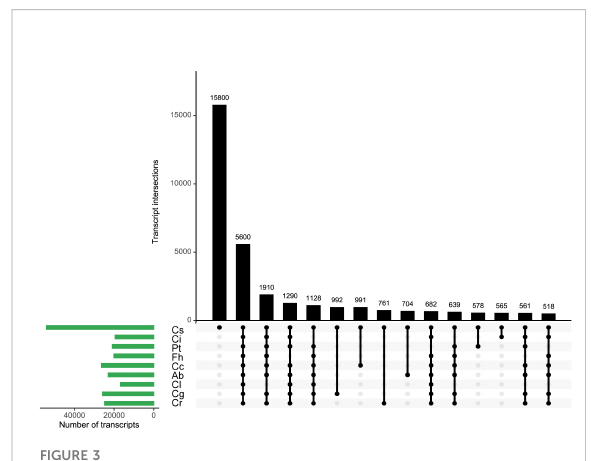
FIGURE 3 Identi fi cation of common and speci fi c transcripts across 9 species. Atalantia buxifolia ; Cc, Citrus clementina ; Cg, Citrus grandis ; Ci, Citrus ichangensis ; Cl, Clausena lansium ; Cr, Citrus reticulata ; Cs, Citrus sinensis ; Fh, Fortunella hindsii ; Pt, Poncirus trifoliata . Database was built using non-redundant reads of Citrus sinensis, sequence similarities were determined using blastn search. The best hit for entry of each species was collected. The 15 largest categories were visualized in an UpSet plot. The number of transcripts in each category was presented in the top barplot. Entry size of different species was shown in the left barplot. Black dots and vertical lines in the lower panel indicate the species to which transcripts